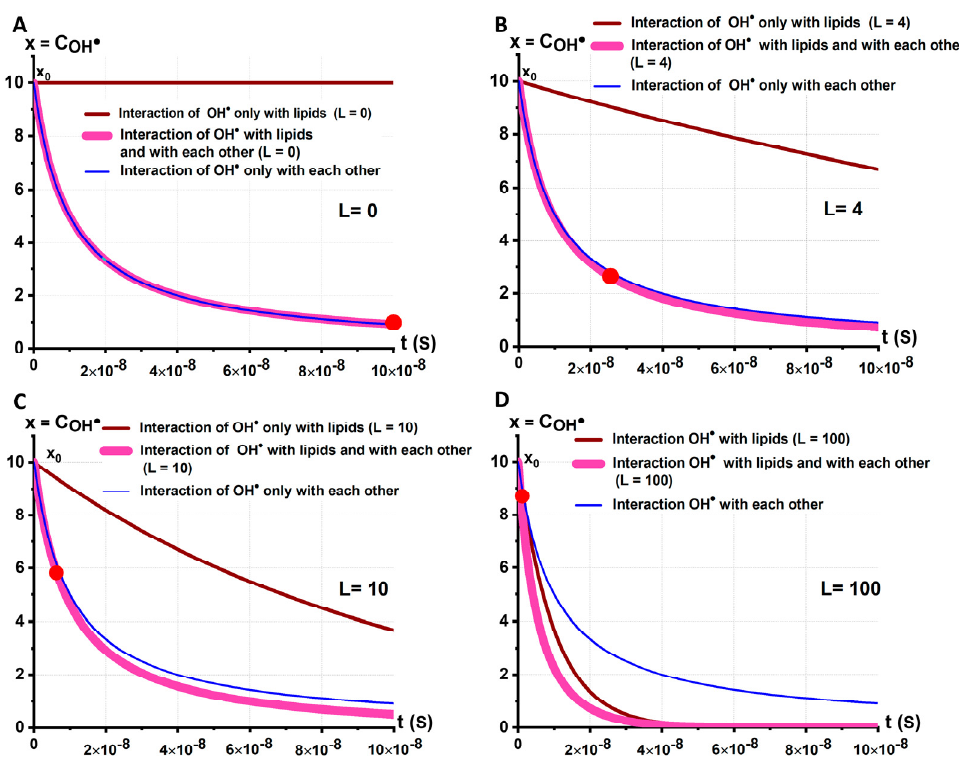
Figure 6. Graphs of the change in x ( t ) (Equation (19)) at different lipid concentrations. ( A ) L = 0, q 1 . ( B ) L = 4, q 2 . ( C ) L = 10, q 3 . ( D ) L = 100, q 4 . Replenishment coefficients: q 1 > q 2 > q 3 > q 4 . Coefficient a = 10 6 , k = 10 7 .